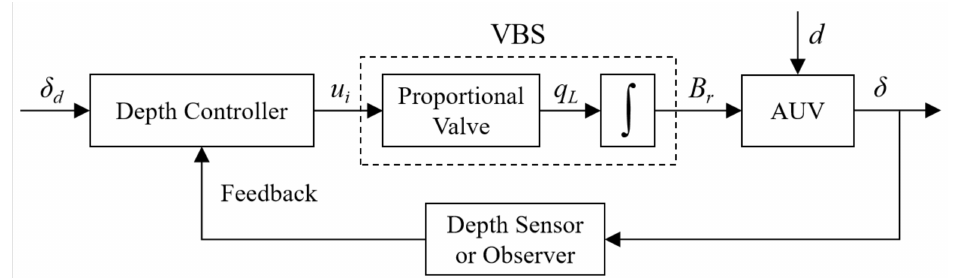
Figure 3. Depth control diagram of